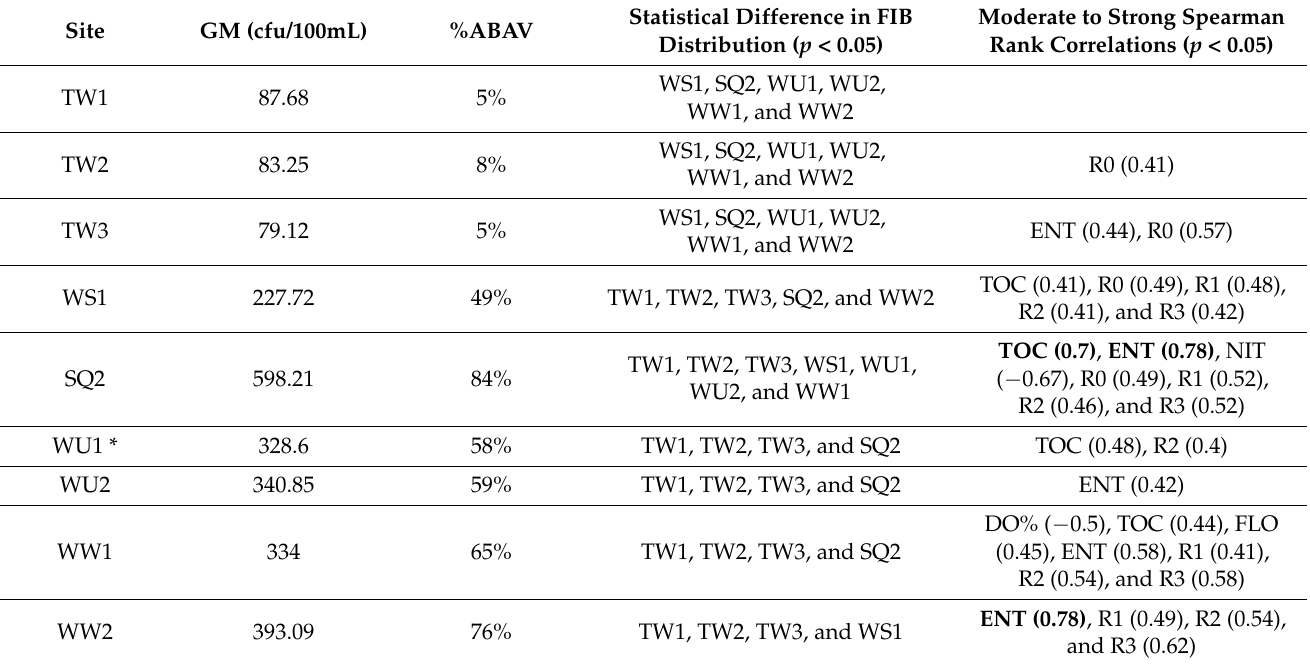
Table 3. Site-specific characterization: E. coli ( n = 38).